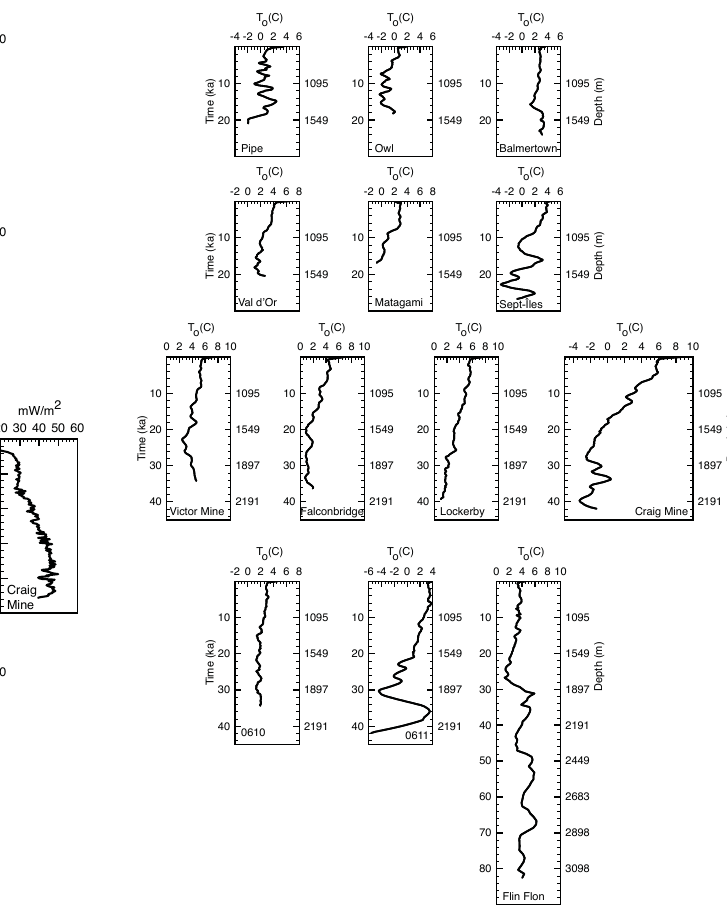
Figure 2. Heat flux variation as a function of depth. Heat flux is calculated as the product of thermal conductivity by the tempera- ture gradient calculated over three points. The Flin Flon, Owl and Matagami profiles have been corrected to account for thermal con- ductivity variations with depth as shown in Table 1.